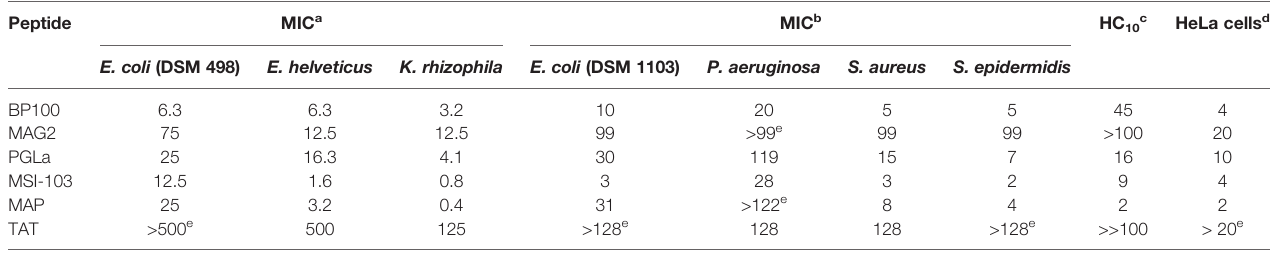
TABLE 2 | Minimum inhibitory concentration of the investigated peptides against tested bacteria, hemolytic activity, and toxicity against HeLa cells (all values in m M). Peptide MIC a MIC b HC 10c HeLa cells d E. coli (DSM